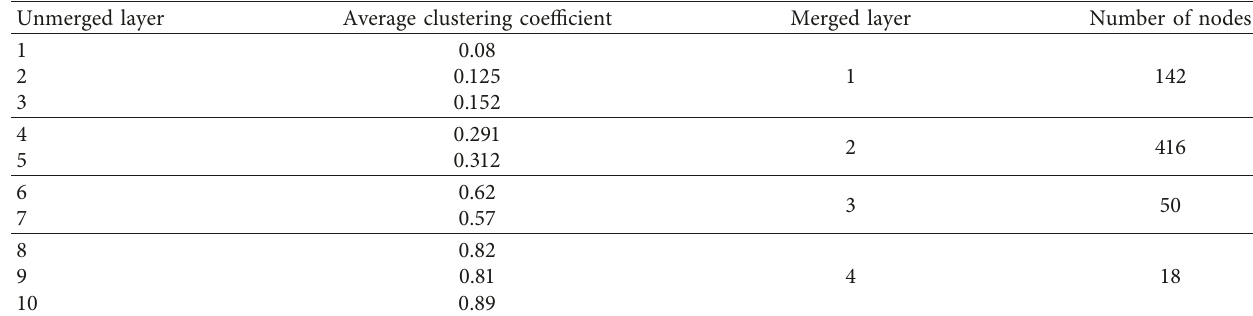
Table 1: Layers of supply chain network of transportation of freight and cargo.